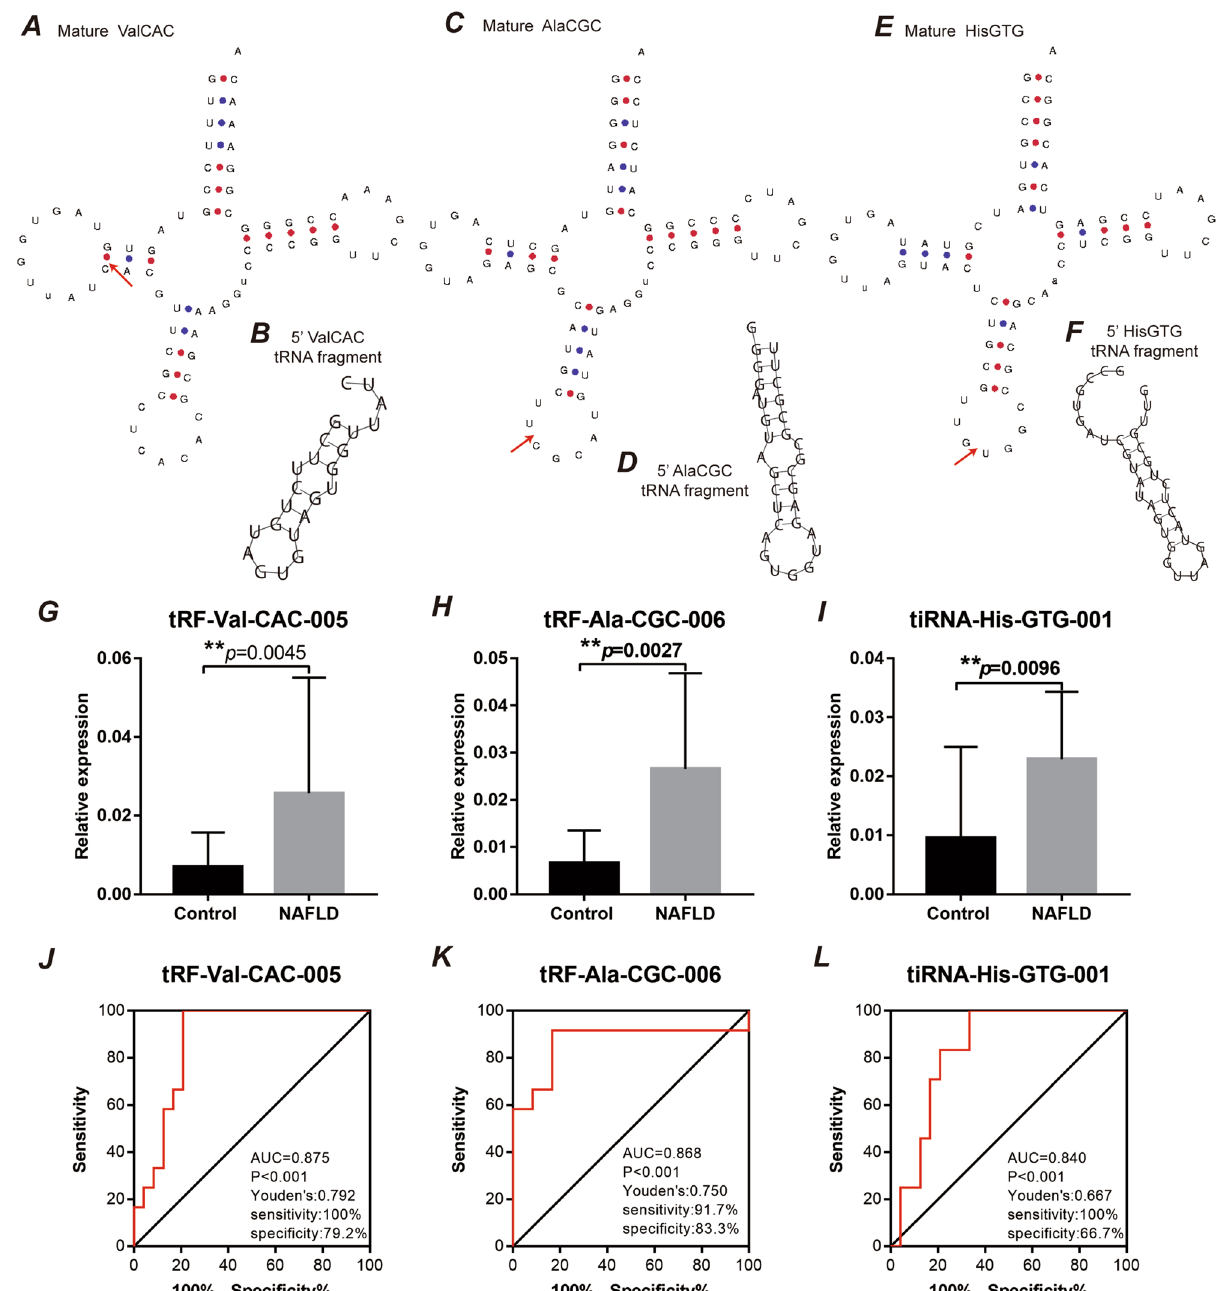
Figure 2. tRNA fragments are elevated in plasma from patients with NAFLD. Blood samples from 114 patients with NAFLD and 42 controls were analysed. (A,C,E) Cleavage sites are indicated (red triangle) on the mature tRNA structures (downloaded from GtRNAdb 2.0). (B,D,F) Predicted secondary structures of the tRNA fragments. (G) tRF-Val-CAC-005, (H) tiRNA-His-GTG-001, and (I) tRF-Ala-CGC-006 were significantly elevated in the NAFLD samples. Student’s t-test indicated p = 0.0045, p = 0.0027, and p = 0.0096, respectively. ** p < 0.01. Data represent the mean ± SEM. ROC curve analysis indicated that (J) tRF-Val-CAC-005 had an AUC of 0.875 ( p < 0.001), (K) tiRNA-His-GTG-001 had an AUC of 0.868 ( p < 0.001), and (L) tRF-Ala-CGC-006 had an AUC of 0.840 ( p <